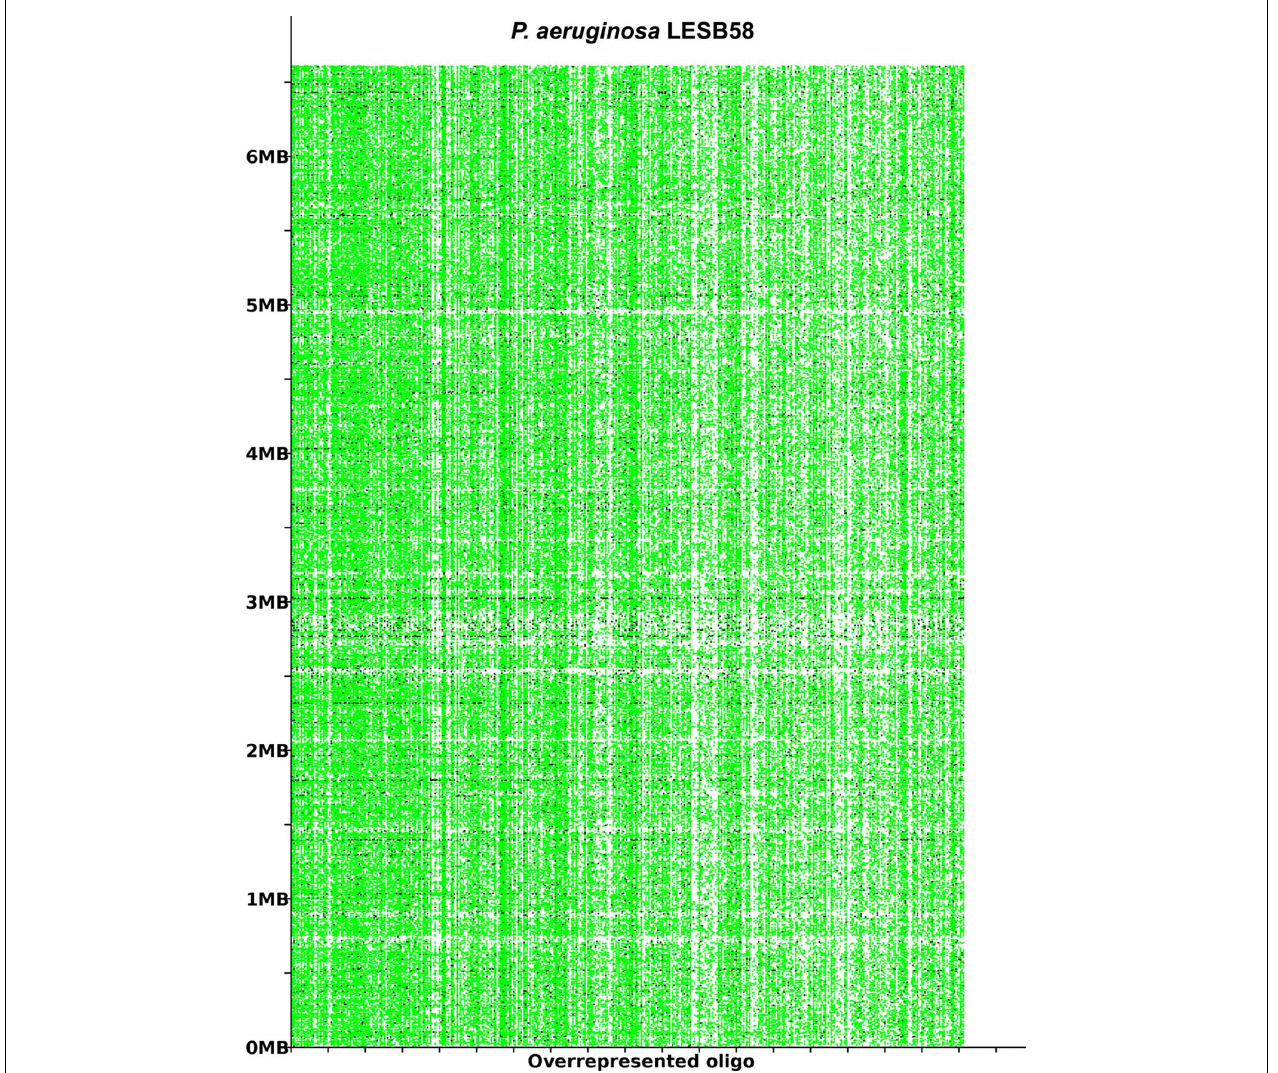
in coding sequences distributed all over the genome; only in the few cases of white vertical lines the respective oligonucleotide clusters in a few genome positions. Horizontal white lines indicate regions with an atypical oligonucleotide usage that lack these strain- or taxon-specific words and represent those parts of the accessory genome that are most foreign from the